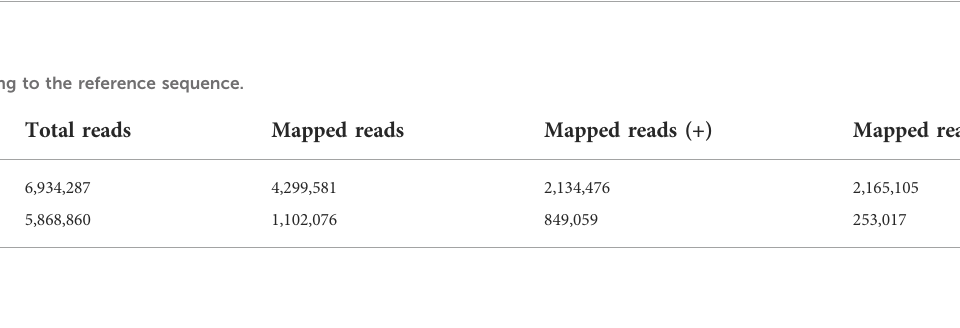
TABLE 3 Known miRNAs